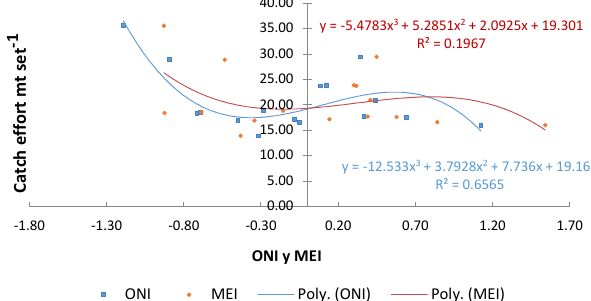
Figure 7. Skipjack fishing effort on FADs and ONI/MEI correlation ( n = 3) for the series 1997–2012. Red (MEI) and blue (ONI). Data NOAA and IATTC